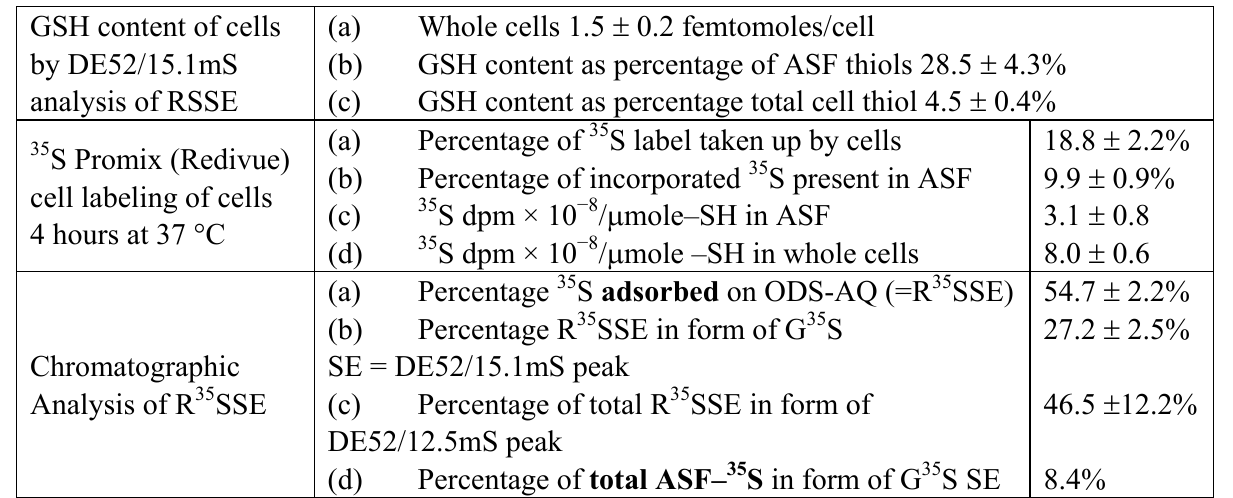
Table 2. Glutathione content and 35 S labeling in LNCap cells using the Ellman